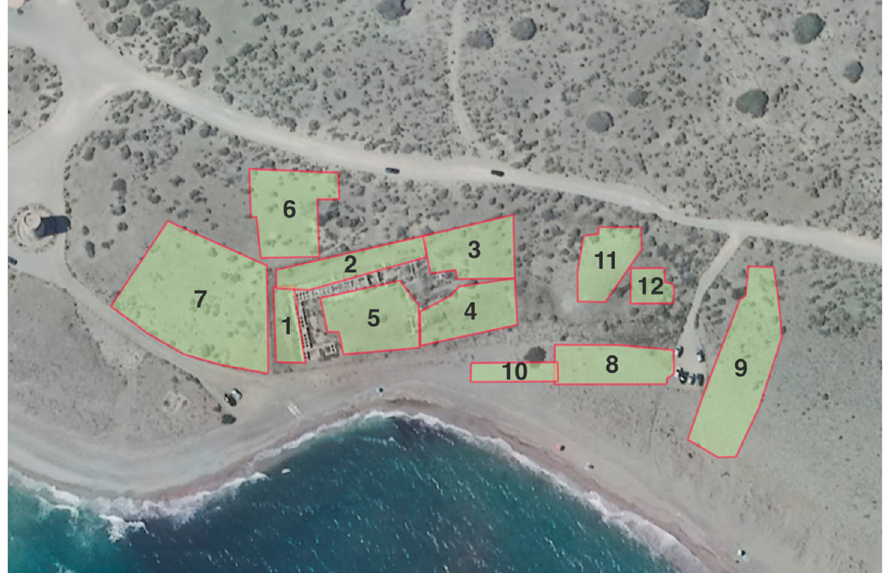
Figure 10. Delimitation of the areas explored with Magnetometer